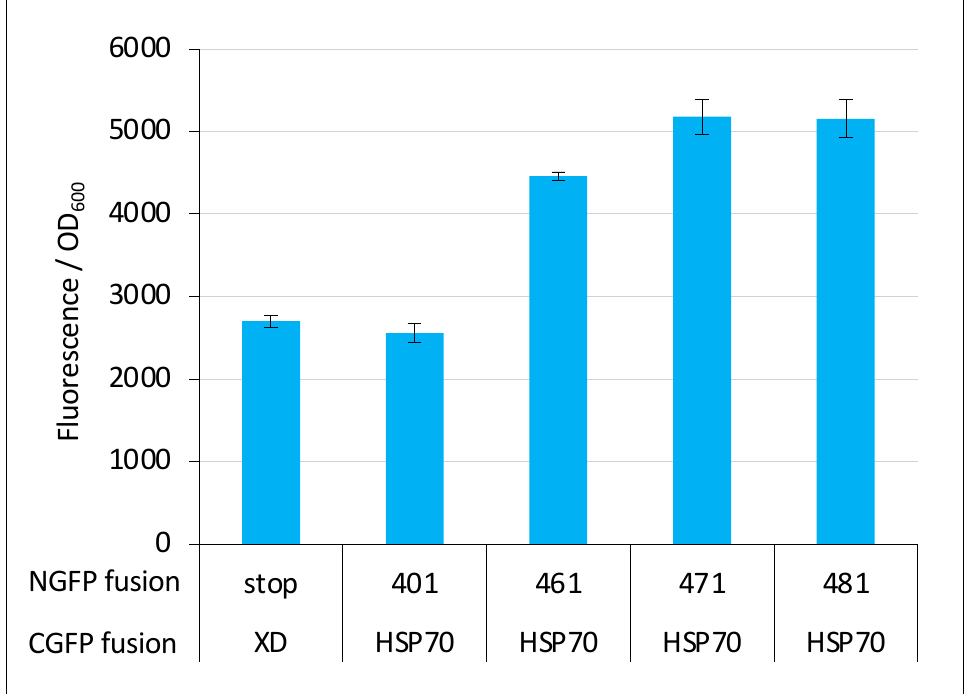
Figure 13. Negative control can be misleading. The fluorescence-to-OD 600 ratio (mean value and standard deviation of a triplicate experiment) of Ntail/XD pairs and Ntail/HSP pairs indicated on the x-axis is reported. NGFP fusions 461, 471 and 481 are N-terminal truncation variants of full length Ntail (401) starting at residue 461, 471 and 481, respectively, instead of residue 401 for full length Ntail. In these truncation variants, the N-terminal fuzzy region located upstream of the MoRE is progressively reduced. The negative control made of the NGFP (referred to as “stop”)/XD-CGFP pair is used as reference. See Figure 1 for details. Data taken from [29] .